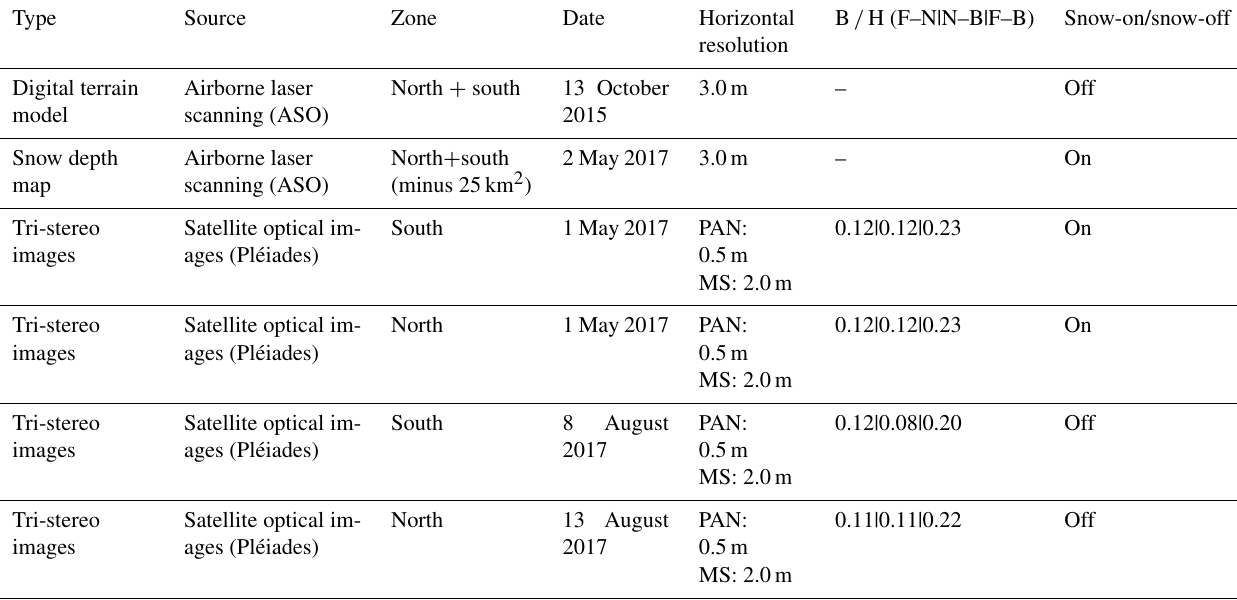
Table 1. Summary of the data used in this study. The base-to-height ratio (B / H) between the front–nadir (F–N), nadir–back (N–B) and front–back (F–B) pair of images is given for the stereo